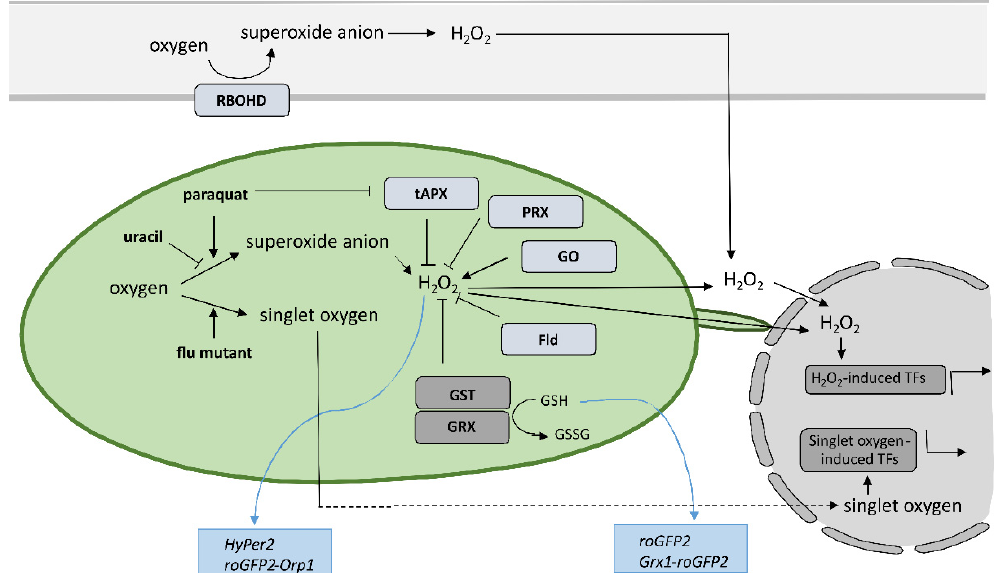
Figure 2. Tools to investigate the role of specific reactive oxygen species produced in chloroplasts and apoplasts. One strategy for studying the role of organelle-specific redox state is by altering reactive oxygen species (ROS) production by using chemicals or mutants (bold) or by altering expression of genes involved in ROS production (light grey). The role of apoplastic ROS could be studied by altering the expression of RBOHD . The role of chloroplastic ROS could be studied in transgenic plants with overexpressed tAPX , which results in decreased chloroplastic ROS production, or in transgenic plants with estrogen-inducible RNAi-silenced tAPX expression, which results in increased chloroplastic ROS production. As PRX similarly as APX reduce H 2 O 2 accumulation, silencing of PRX results in enhanced chloroplastic H 2 O 2 production. Fld improves the delivery of reducing equivalents to productive pathways of the chloroplast, which in turn restricts chloroplastic ROS production. Paraquat acts by re-directing electrons from photosystem I to oxygen and thereby enhances the production of superoxide in the chloroplasts but also inhibits APX, which leads to accumulation of H 2 O 2 in treated plants. Flu mutant is used to study singlet-oxygen-specific ROS signaling. Uracil, acting as a chloroplast electron transport chain inhibitor, reduces H 2 O 2 production. Different types of ROS induce specific transcriptional response. Another strategy for studying the role of organelle-specific redox state is by using biosensors (blue). roGFP2 and Grx1-roGFP2 targeted to chloroplasts measure chloroplast redox state, while roGFP2-Orp1 and HyPer-derived probes detect H 2 O 2 . RBOHD: respiratory burst oxidase homolog (RBOH) NADPH oxidases D, tAPX: thylakoidal ascorbate peroxidase,